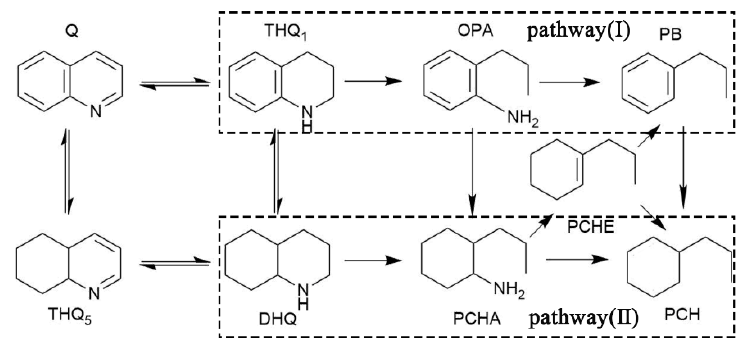
Figure 12. The HDN reaction network of quinoline.